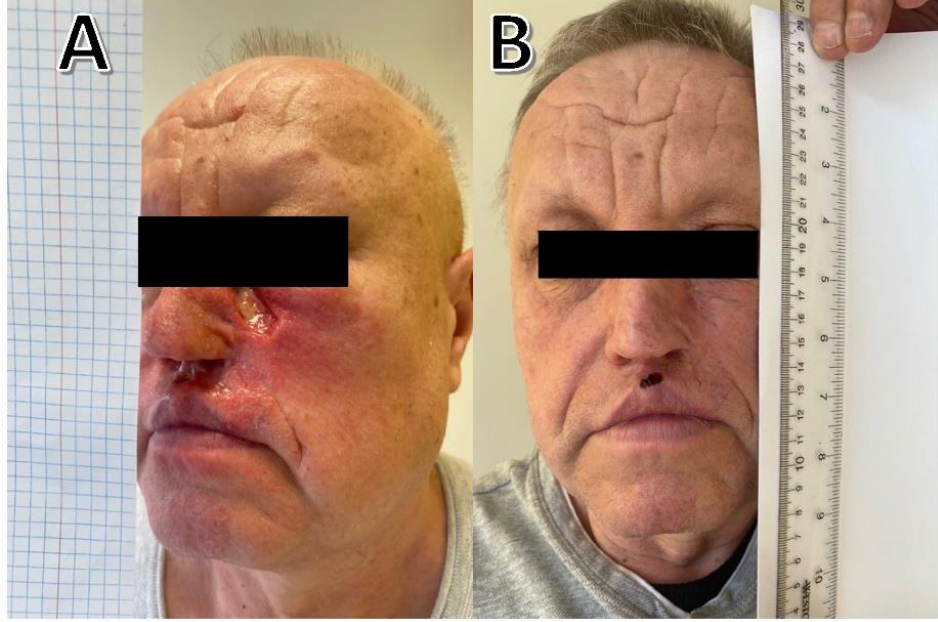
Figure 2. ( A ) Before treatment; ( B ) After 3 administrations of cemiplimab (9 weeks).